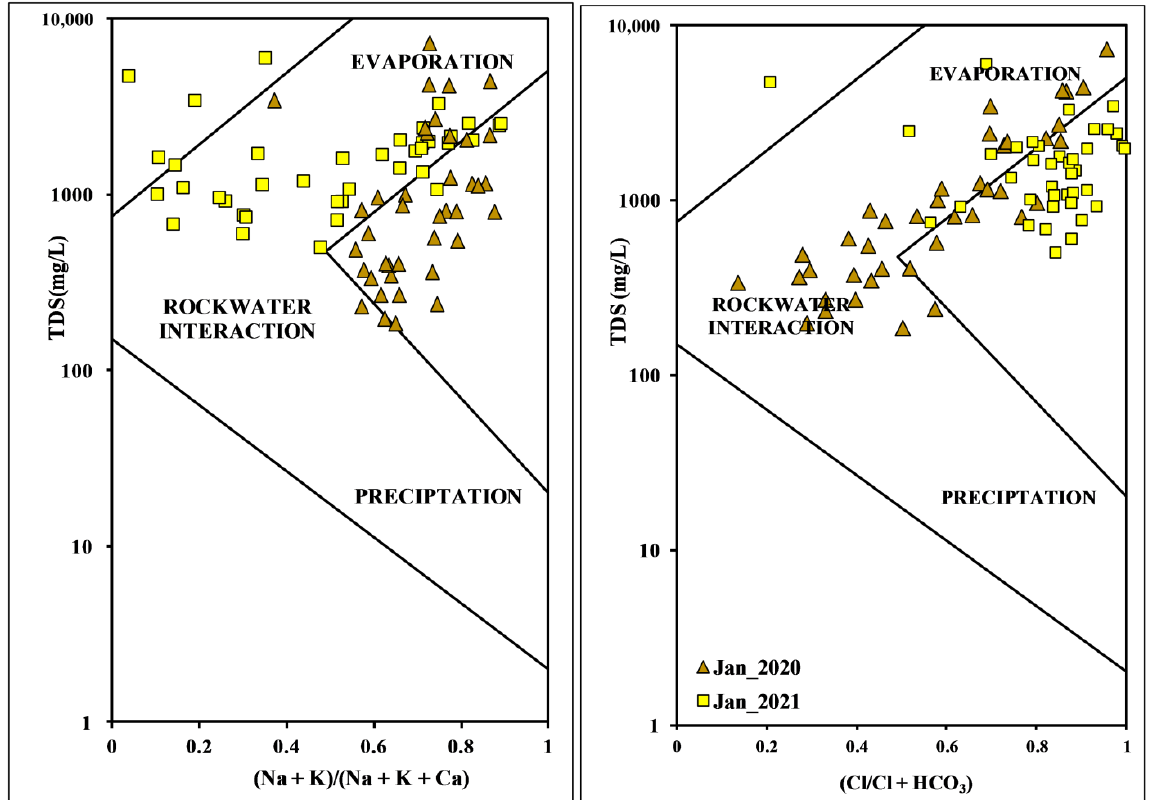
Figure 9. Mechanisms that control groundwater chemistry, as depicted by Gibb’s plots.